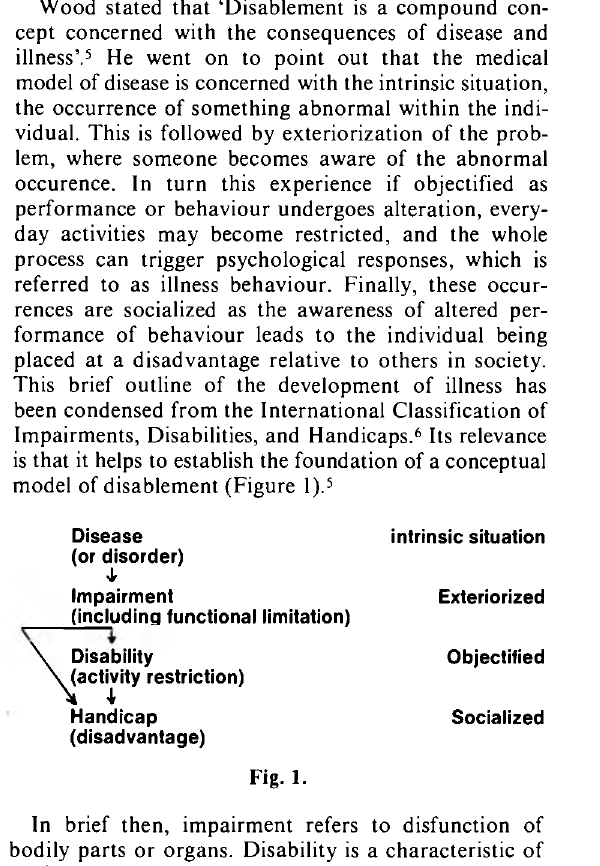
Table 1. Female age-specific motor impairment rates per 1000 for walking disability